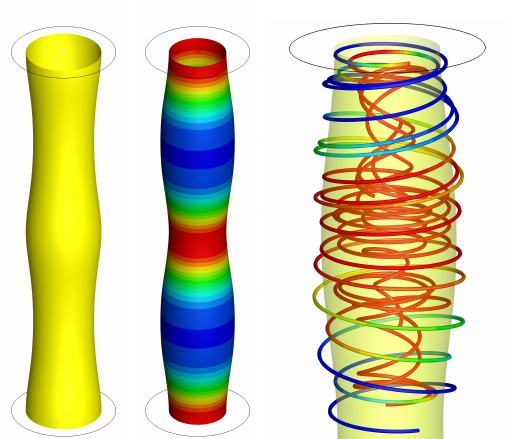
Figure 3. Inviscid vortex filament initiated by the velocity field (16); initial potential field φ o ( left ), potential field at t = 6 decorated by the local kinetic energy ( center ), and a snapshot of stream- lines ( right